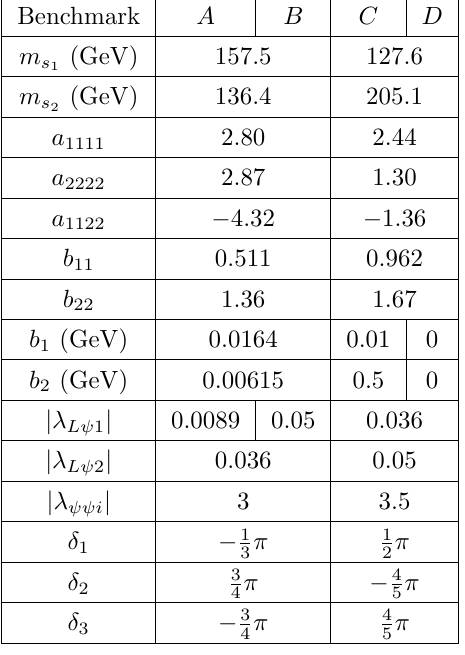
Table 1. Benchmark point parameters. Parameters not listed here are the same for all the bench- mark points, and are given in table 2. Phases were selected to maximise the baryon asymmetry.